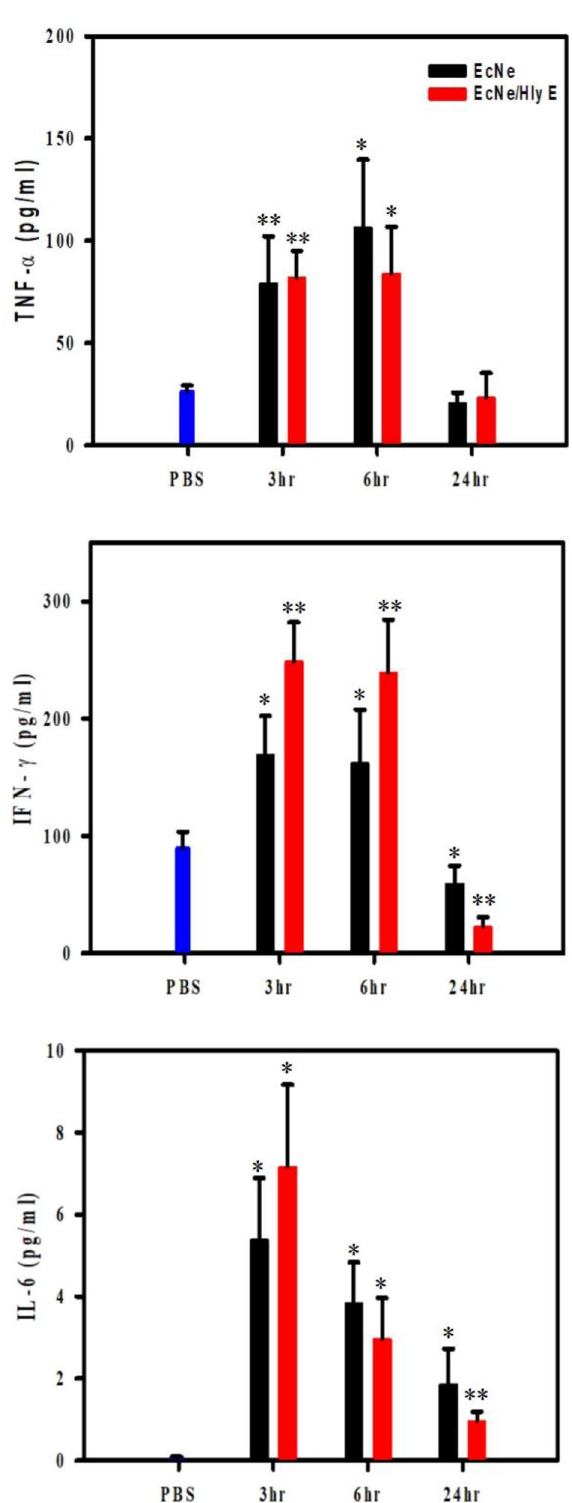
Figure 7. Investigation of immune responses in mice. C57BL/6 mice were treated with systemic administration of PBS, EcNe or EcNe/HlyE for four consecutive days. Since then, their serum levels of TNF-α, TNF-γ and IL6 in C57BL/6 mice were quantified at the indicated time three time points. Values were expressed as means ± SD (* p < 0.05; ** p < 0.01; and *** p < 0.001 vs. the PBS